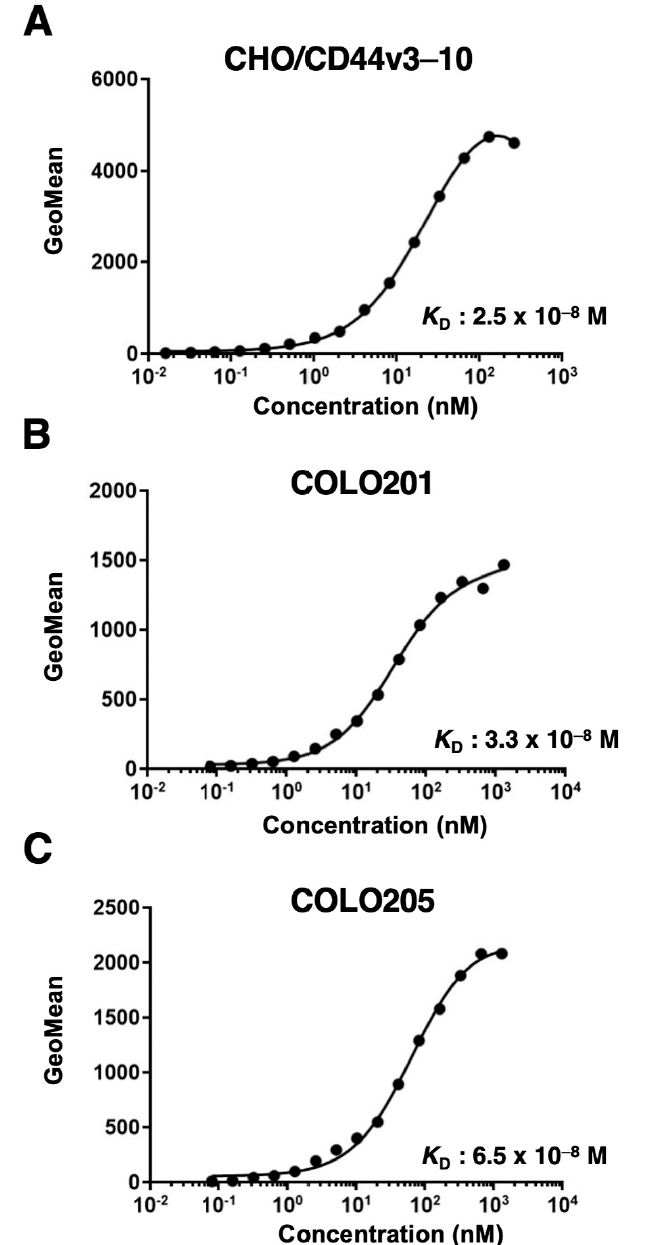
Figure 3. The determination of the binding affinity of C 44 Mab-1. Serially diluted C 44 Mab-1 at indicated concentrations was treated with CHO/CD44v3–10 ( A ), COLO201 ( B ), and COLO205 ( C ). Then, cells were treated with anti-mouse IgG conjugated with Alexa Fluor 488. Fluorescence data were collected, followed by the calculation of the apparent dissociation constant ( K D ) by GraphPad PRISM